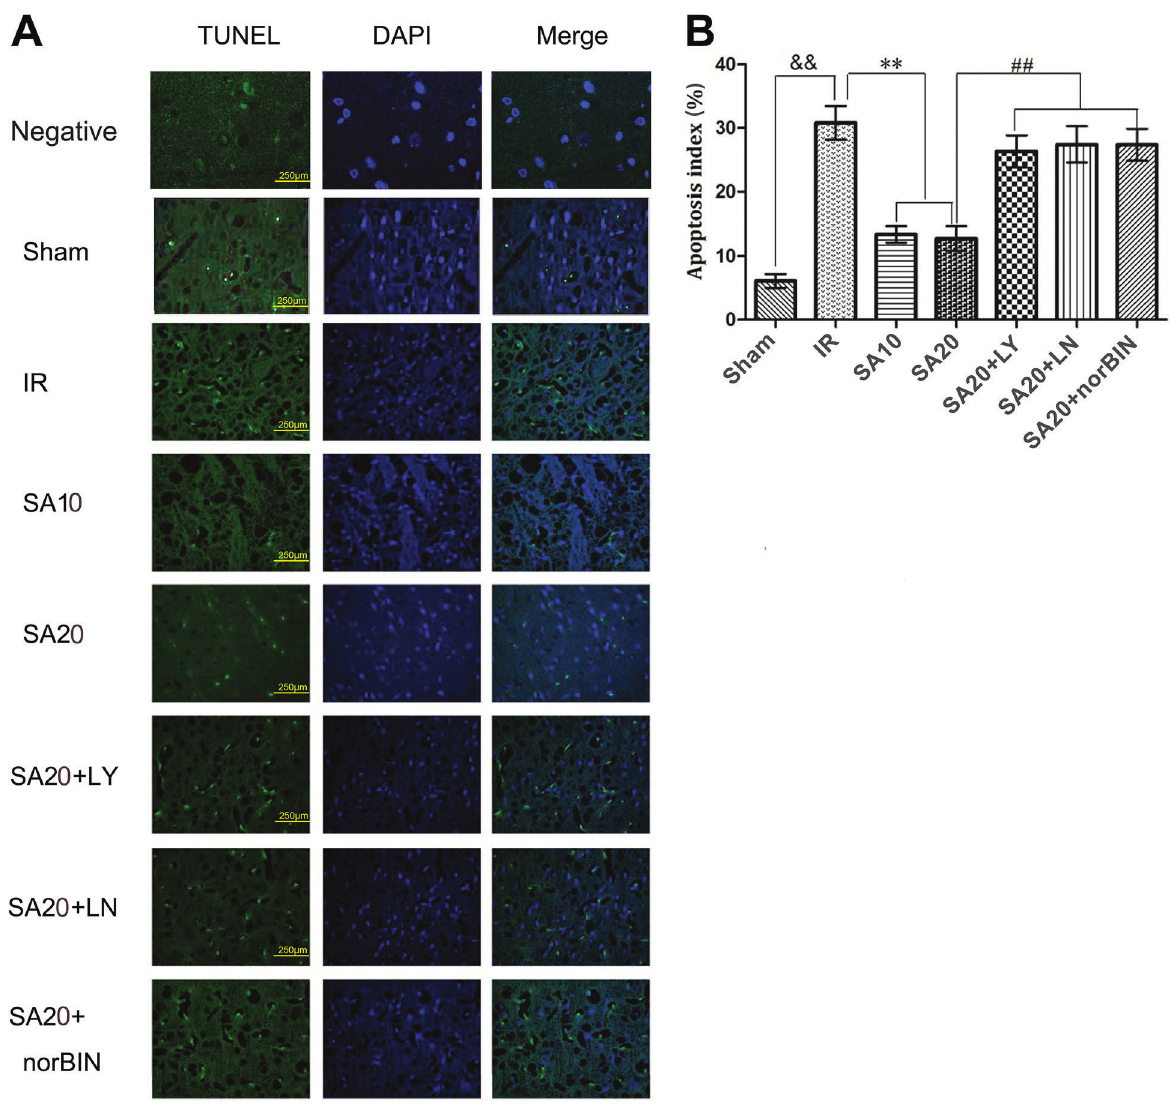
Figure 6. Determination of the cell apoptosis in the cerebral cortex by TUNEL staining. A , Representative TUNEL staining images among different treatment groups showed obvious cell apoptosis and increased numbers of apoptotic positive cells after cerebral cortex ischemia for 10 min. Scale bar, 250 m m. The negative control group was without the streptavidin-horseradish peroxidase. B , Quantitative analysis of cell apoptosis. Data are reported as means ± SD for n=6. && P o 0.01 compared to the sham control group. **P o 0.01 compared to the IR (DMSO) group, ## P o 0.01 compared to the salvinorin A2 treatment group. Cell apoptosis was analyzed by one-way ANOVA followed by Tukey ’ s test. LY: LY294002 (10 m M, topically injected); LN: L-NAME (10 m M, injected topically); IR (ischemia reperfusion control, DMSO): 1 m L/kg ( iv ); SA10: salvinorin A (10 m g/kg, iv ); SA20: salvinorin A (20 m g/kg, iv ); norBIN: norbinaltorphimine 1 m M (injected